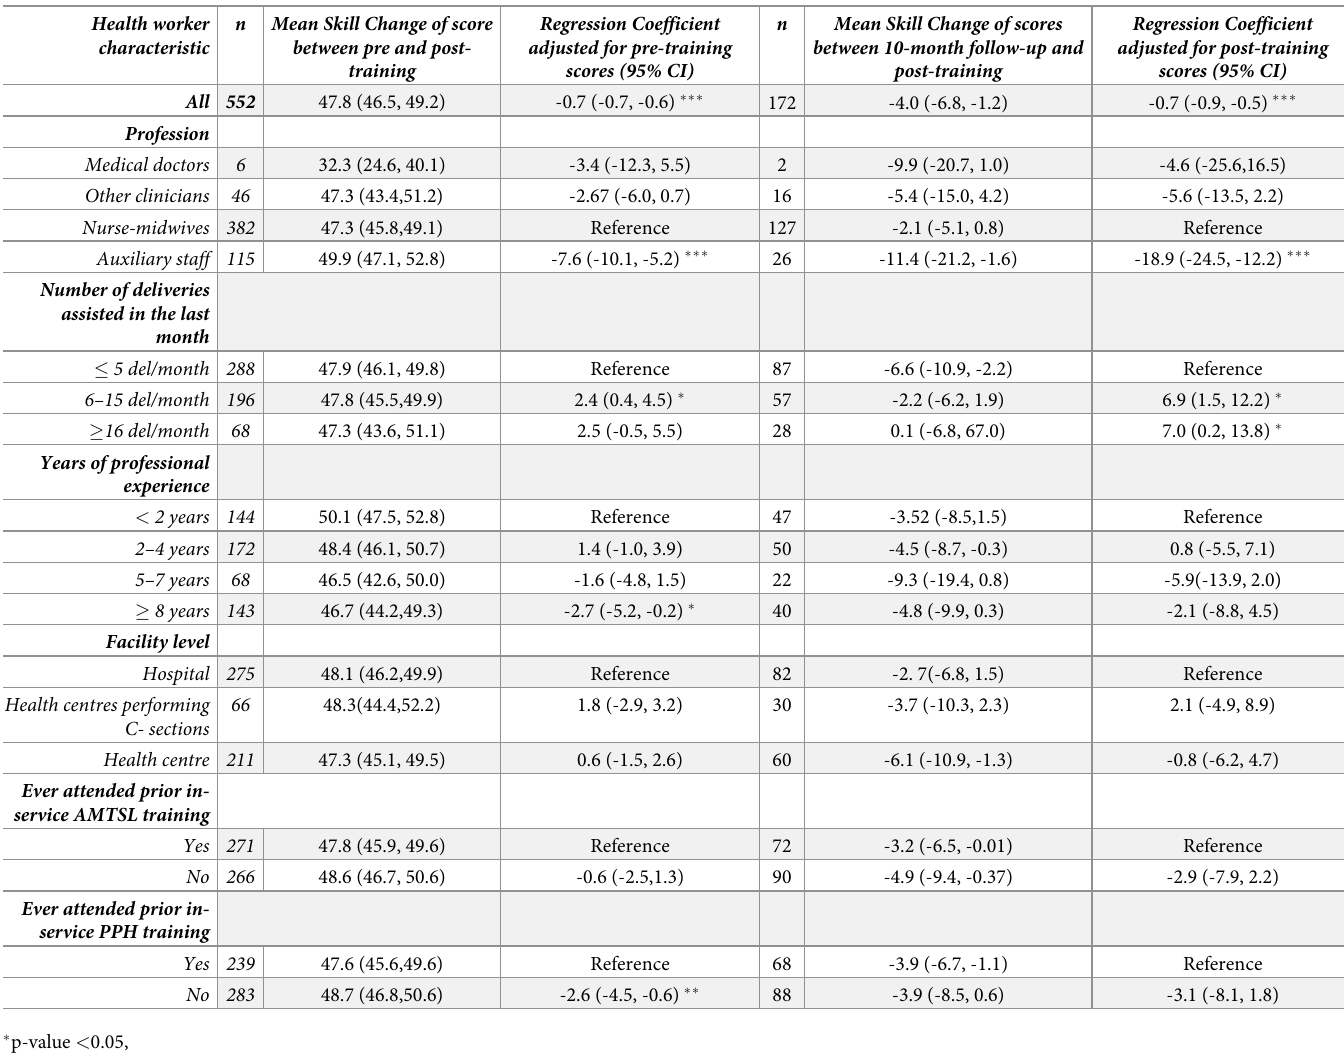
Table 3. Linear regression for mean skill changes immediately post-training and at 10-month follow-up of HMS BAB